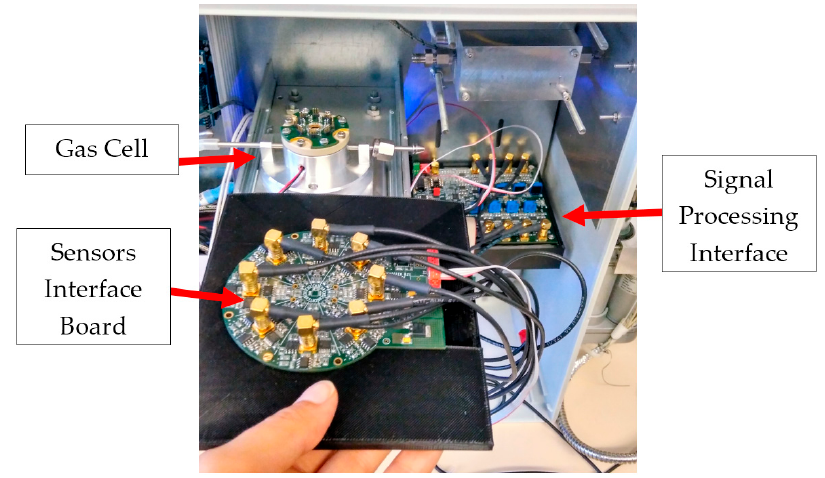
Figure 3. Integrated gas analysis cell and electronic circuits.